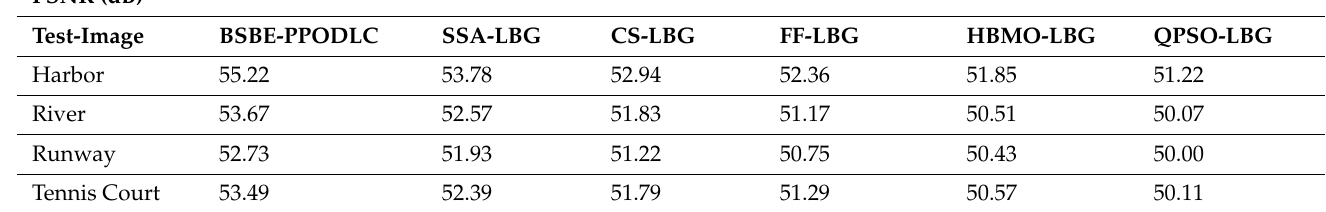
Table 3. PSNR analysis outcomes of the proposed BSBE-PPODLC method with other methods for distinct test